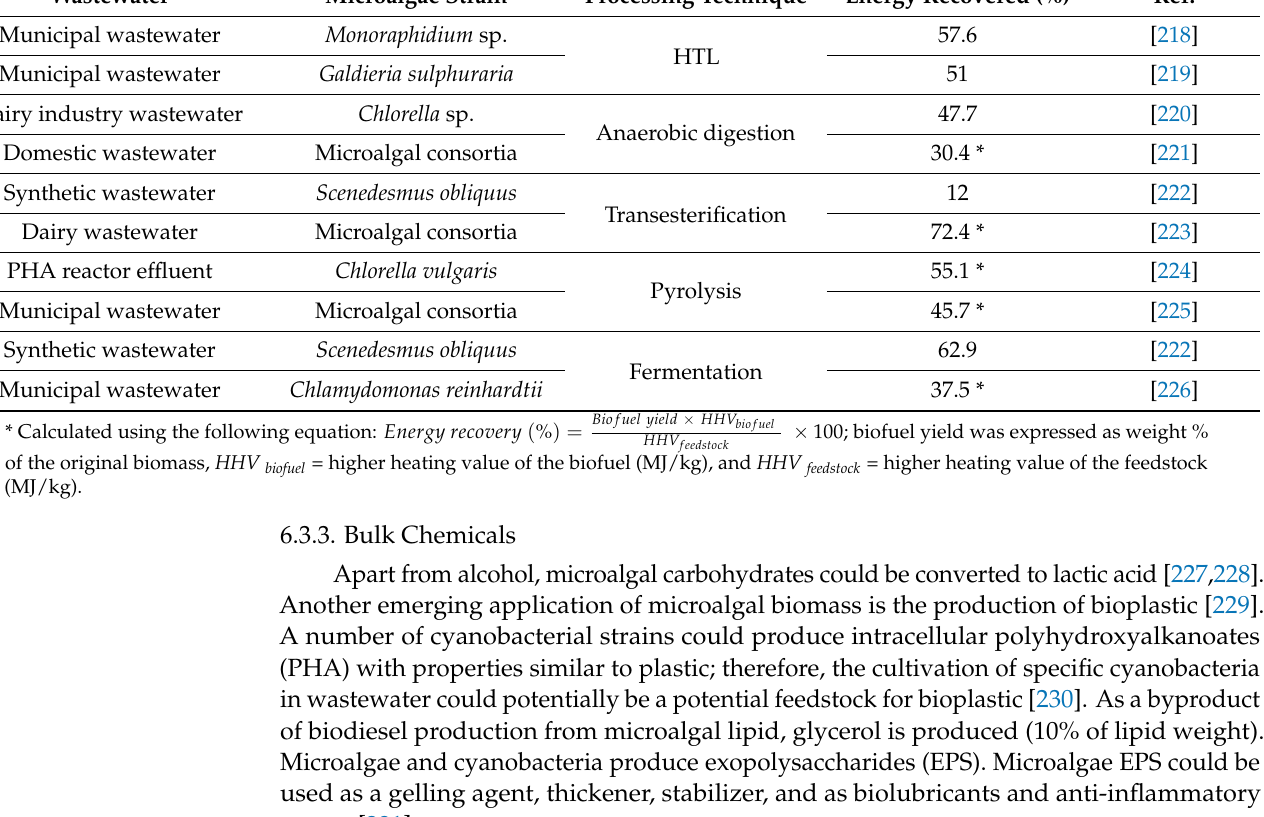
Table 6. Energy recovered from wastewater-grown microalgal biomass using different conversion techniques. Wastewater Microalgae Strain Processing Technique Energy Recovered (%)